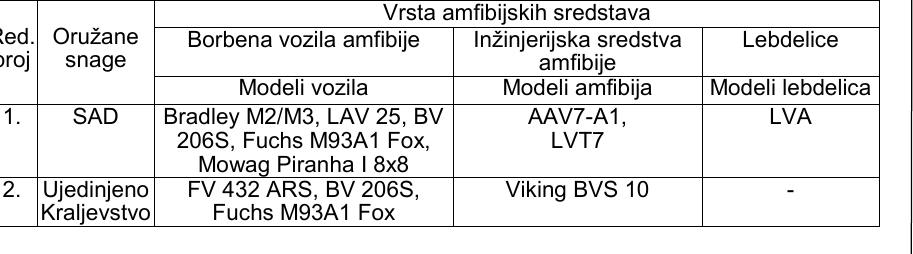
Table 1 – List of the amphibious assets in the NATO countries Vrsta amfibijskih sredstava Oružane Borbena vozila amfibije Inžinjerijska sredstva snage broj amfibije Modeli vozila Modeli amfibija Modeli